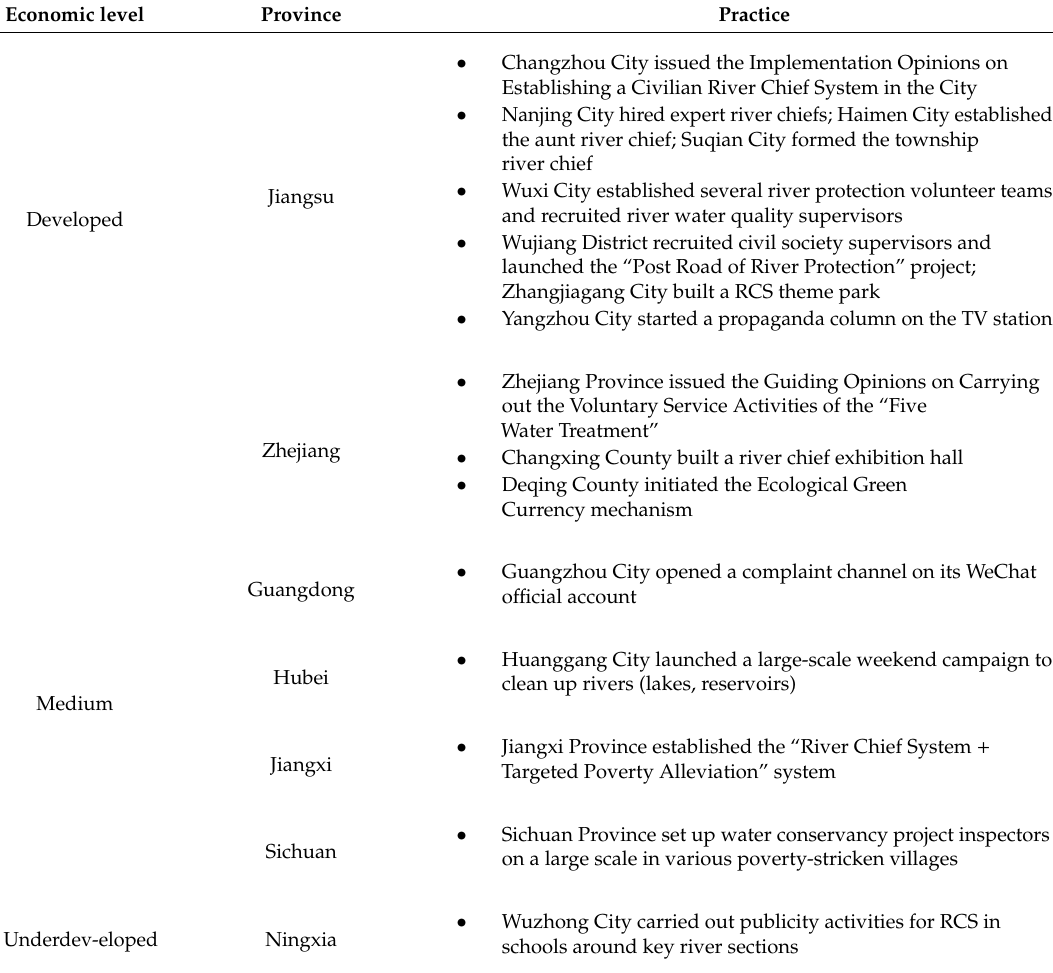
Table 1. Public Participation in the RCS in Provinces with Di ff erent Economic